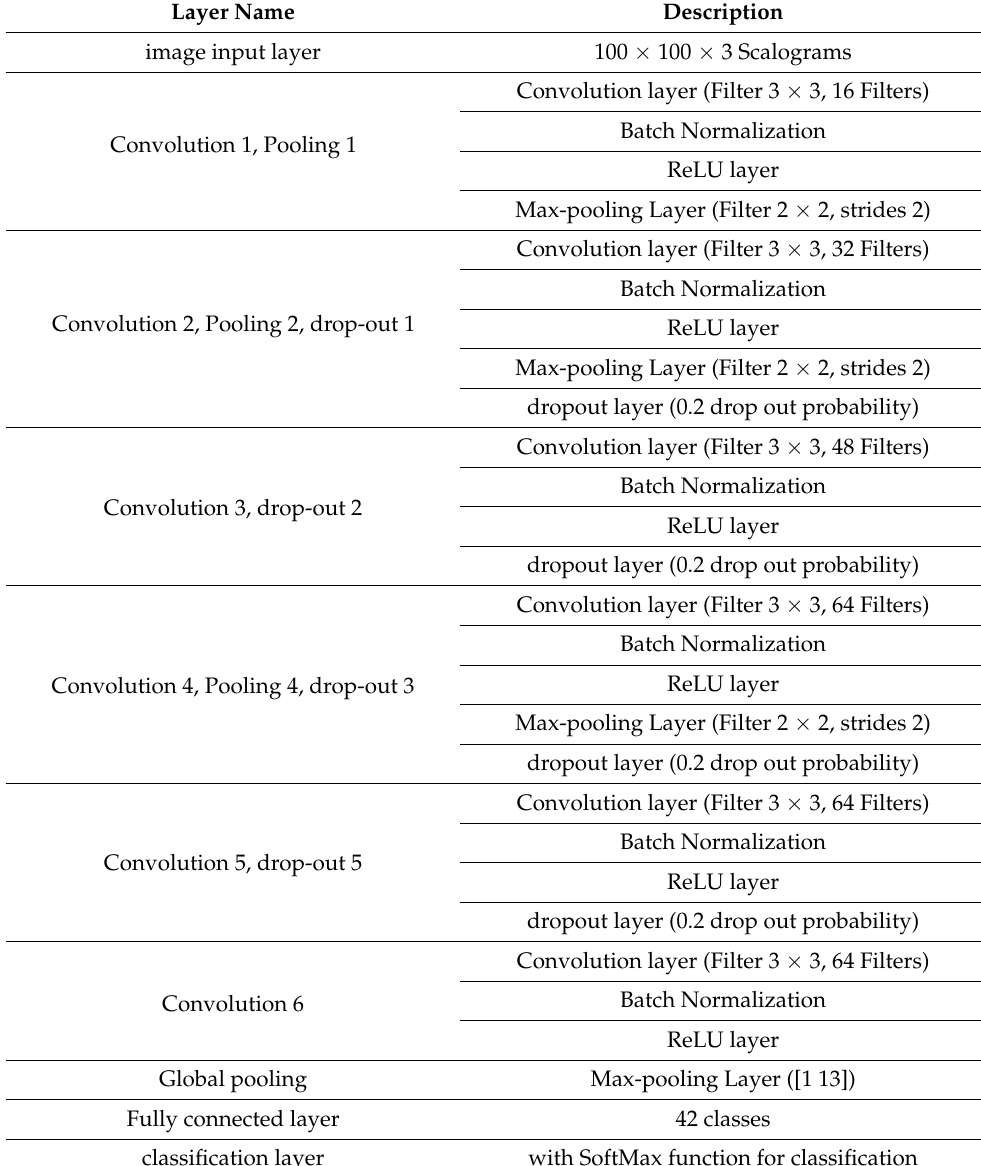
Table 3. Architectural details of the customized deep learning model.